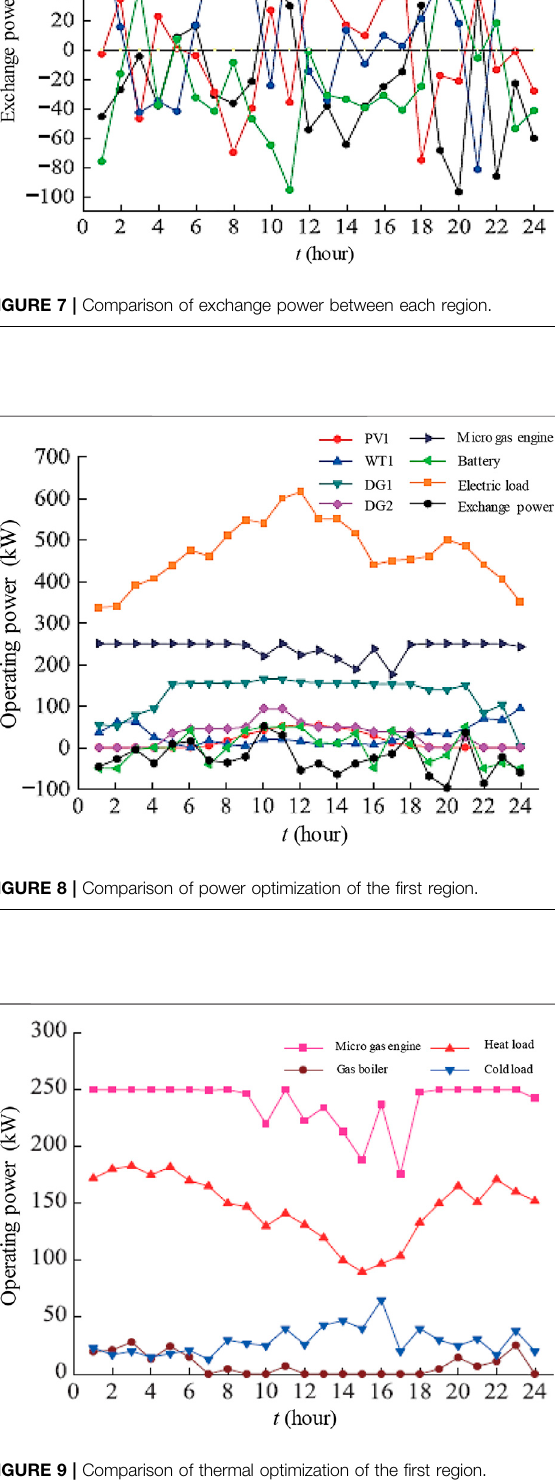
FIGURE 9 | Comparison of thermal optimization of the fi rst